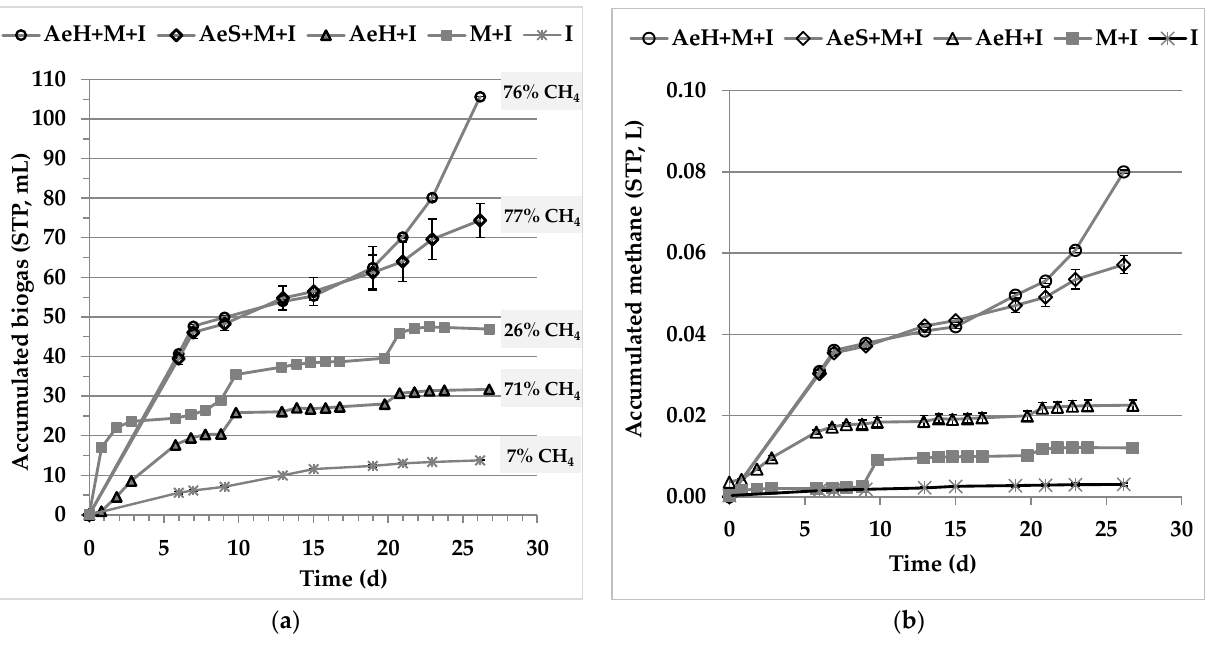
Figure 1. Anaerobic digestion of wastes from fermentation: ( a ) cumulative biogas production; ( b ) cumulative methane production. STP—standard temperature and pressure. The values presented for the percentage of methane refer to the last day of the experiment.